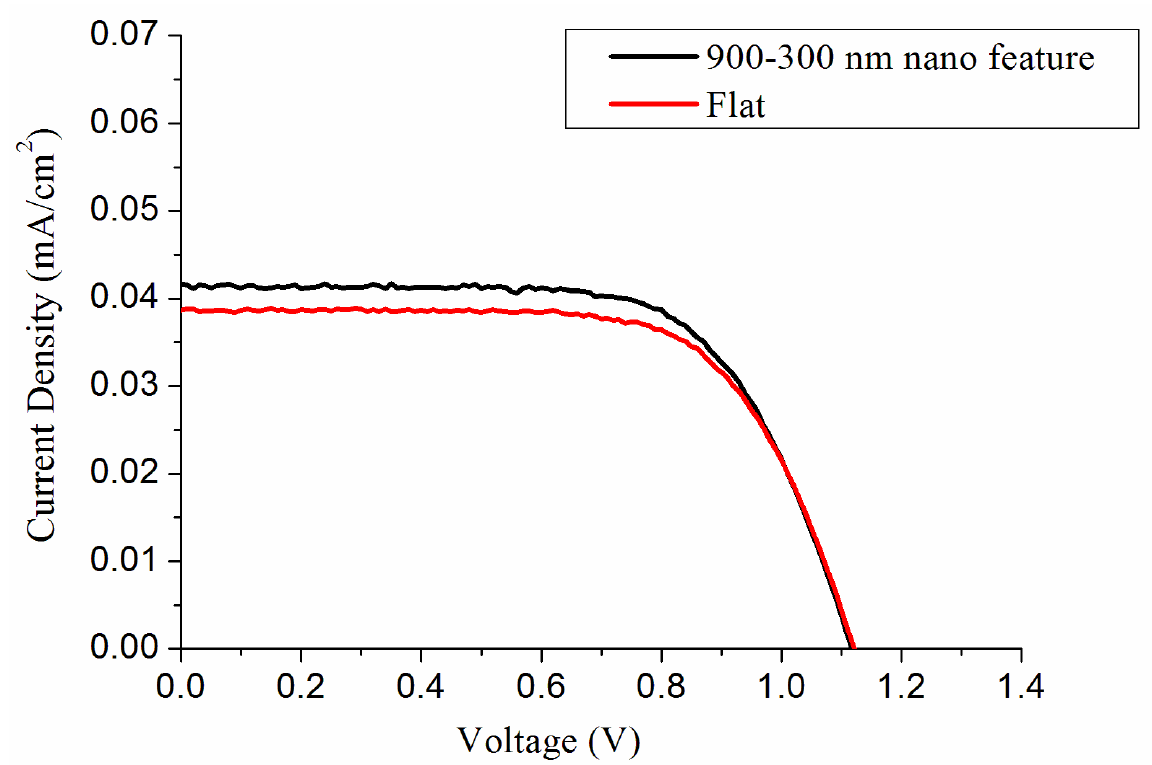
Figure 7. Effect of nanofeatured films on the current-voltage (I-V) characteristics of solar cell. Table 2. I-V properties of solar cells with flat film and binary nanofeatured film. Solar Cell